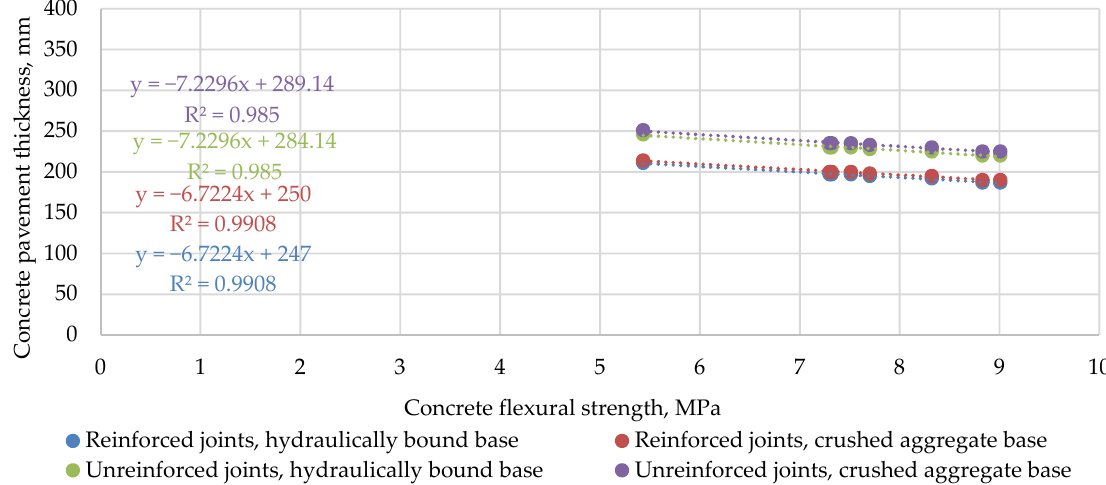
Figure 5. The relationship between the calculated PCP thickness according to the RDO Beton 09 method and the concrete tensile splitting strength.